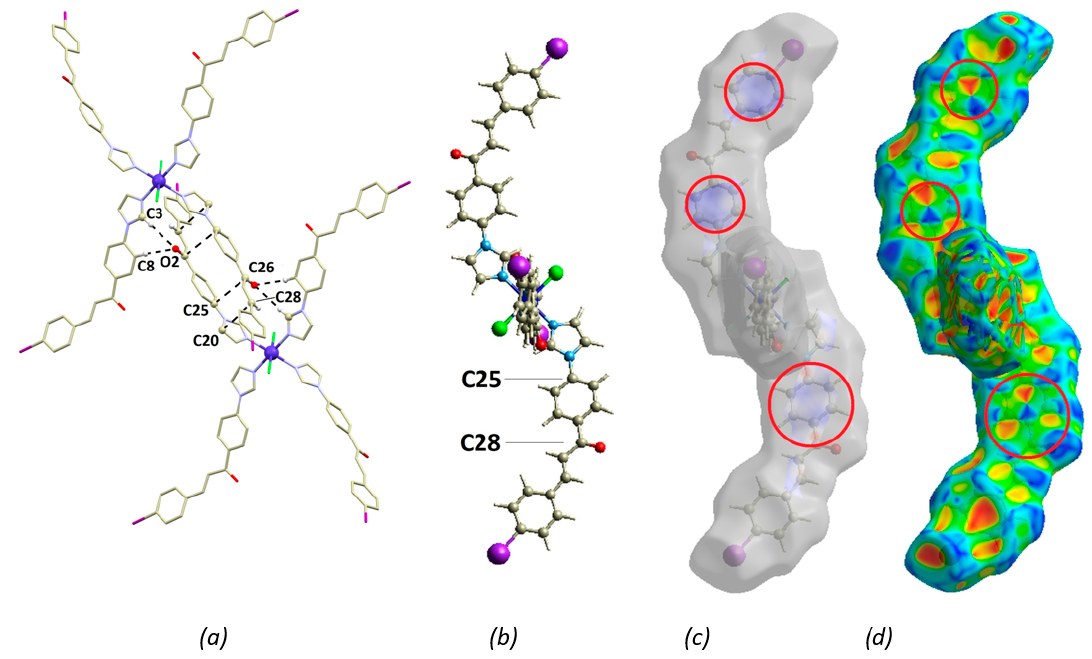
Figure 4. ( a ) A perspective view on π - π stacking interactions and bifurcated C − H ··· O hydrogen bonding involving chalcone keto group. Donor-acceptor distances of displayed interactions: d (C20 ··· C28) = 3.357(5) Å, d (C25 ··· C26) = 3.290(5) Å, d (C3 ··· O2) = 3.421(6) Å, d (C8 ··· O2) = 3.193(5) Å. The non-covalent interactions were depicted as black dashed lines. Hydrogen atoms (except for those involved in hydrogen bonding) were omitted for clarity. The drawing of molecular structure of 1b with the atom labels of the carbon atoms involved in short C ··· C contacts ( b ). Calculated Hirshfeld surfaces (d norm ) with highlighted areas of the C ··· C interactions (colored maps in red circles, c ) and shape-index surface with highlighted areas involved in π - π stacking interactions (red circles, d ).